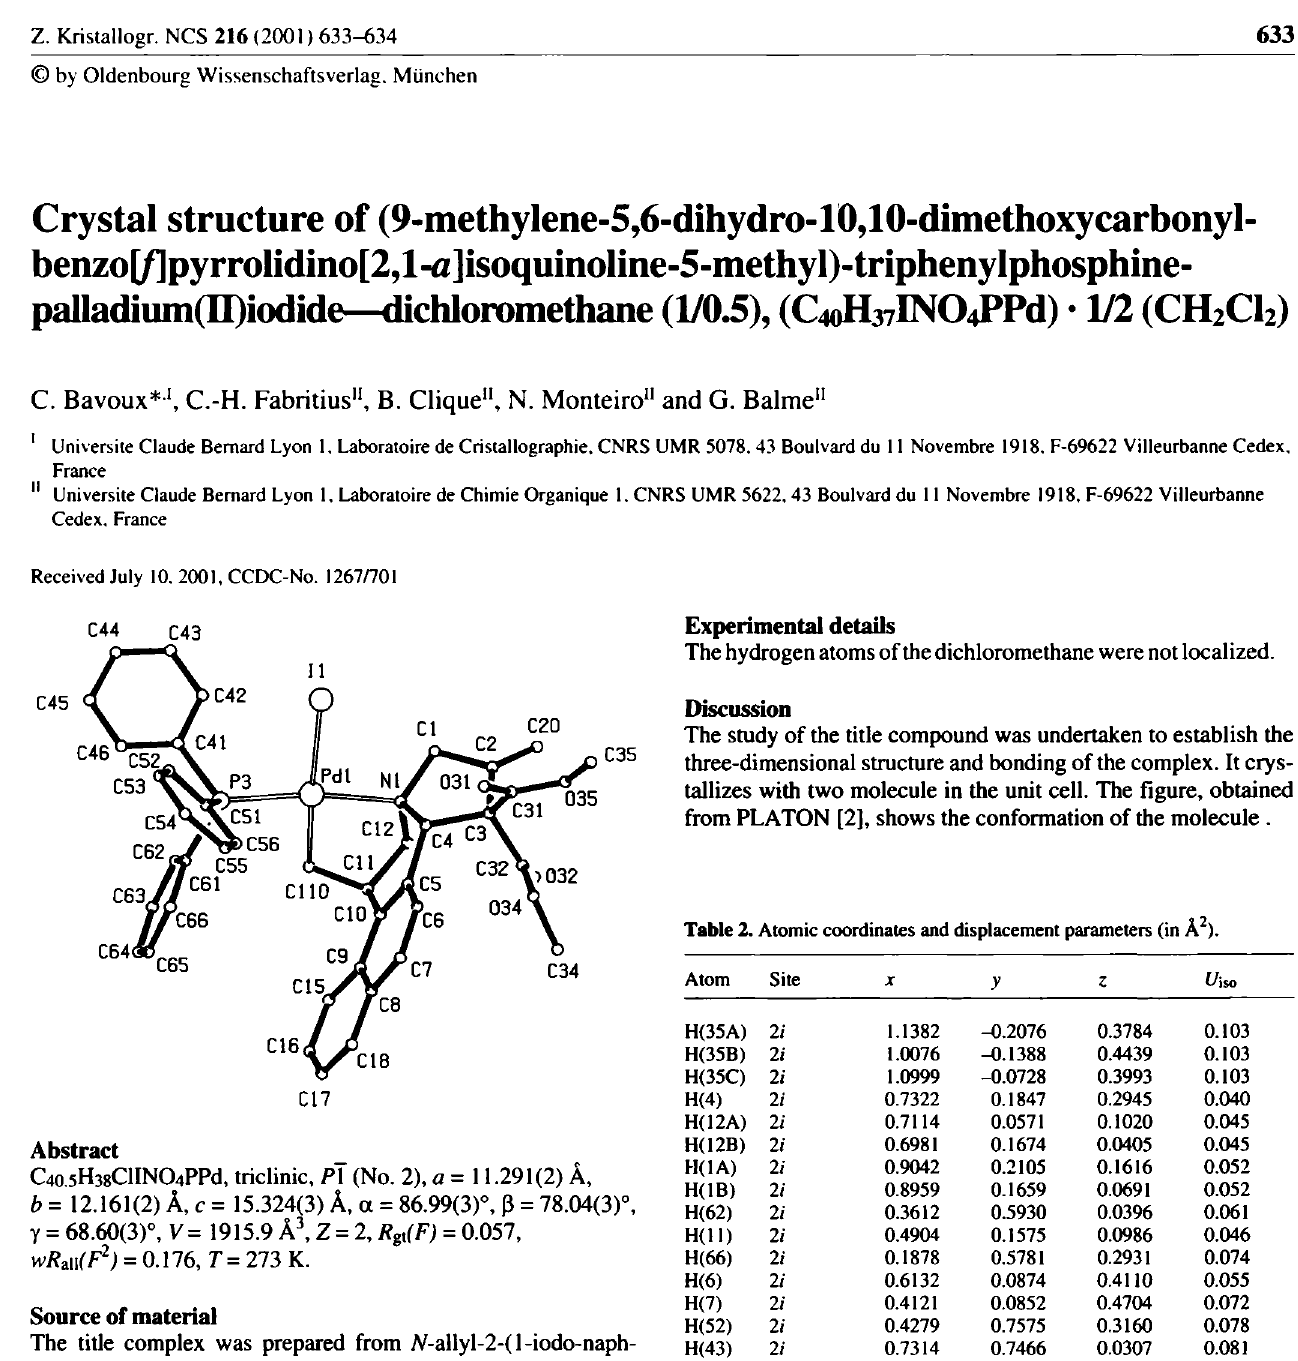
Table 2. Atomic coordinates and displacement parameters (in Ä 2